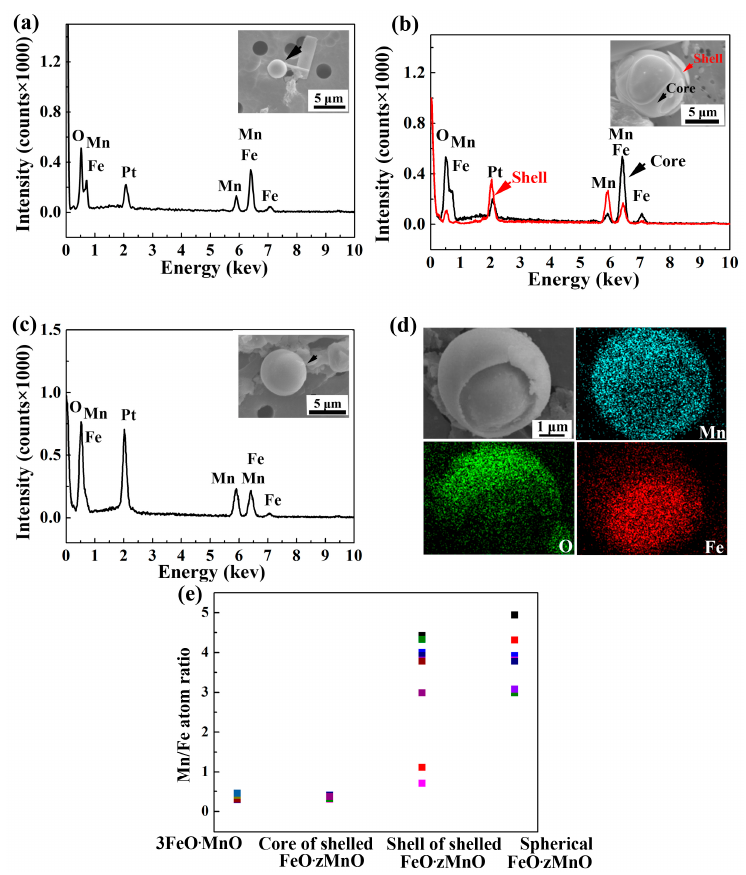
Figure 3. ( a ) Morphology (black arrow) and EDS spectrum of the spherical inclusions typical of S1. The Pt peak is derived from the platinum plating that is applied to the inclusions before analysis. On average, S1 inclusions are smaller than S2 inclusions. ( b ) Morphology and EDS spectrum of the inner core (black arrows) and outer shell (red arrows) of the shelled inclusions that occur in S2. ( c ) Morphology and EDS spectrum of the unshelled spherical inclusions that also occur in S2. ( d ) Mapping analysis of the distribution of Mn, O, and Fe elements in shelled inclusions. Note that the intensity of Mn and O elements is high in the outer area (shell) and weak in the inner area (core), but that of Fe is high in the core and weak in the shell. ( e ) Composition analysis of MnO-FeO oxide inclusions in S1 and S2. The first two columns on the left show that the Mn/Fe ratio for all S1 inclusions (calculated to be 0.36 ± 0.09) is at the same level as for the core of shelled inclusions in S2 (0.35 ± 0.05). The last two columns on the right show that the Mn/Fe ratio for S2 spherical inclusions (average of 4 with maximum 5 and minimum 3) is at the same level as for the shells alone in the S2 shelled inclusions (average of 2 with maximum 4 and minimum 0.7), and the shell has a wider ratio range from 0.7 to 4.